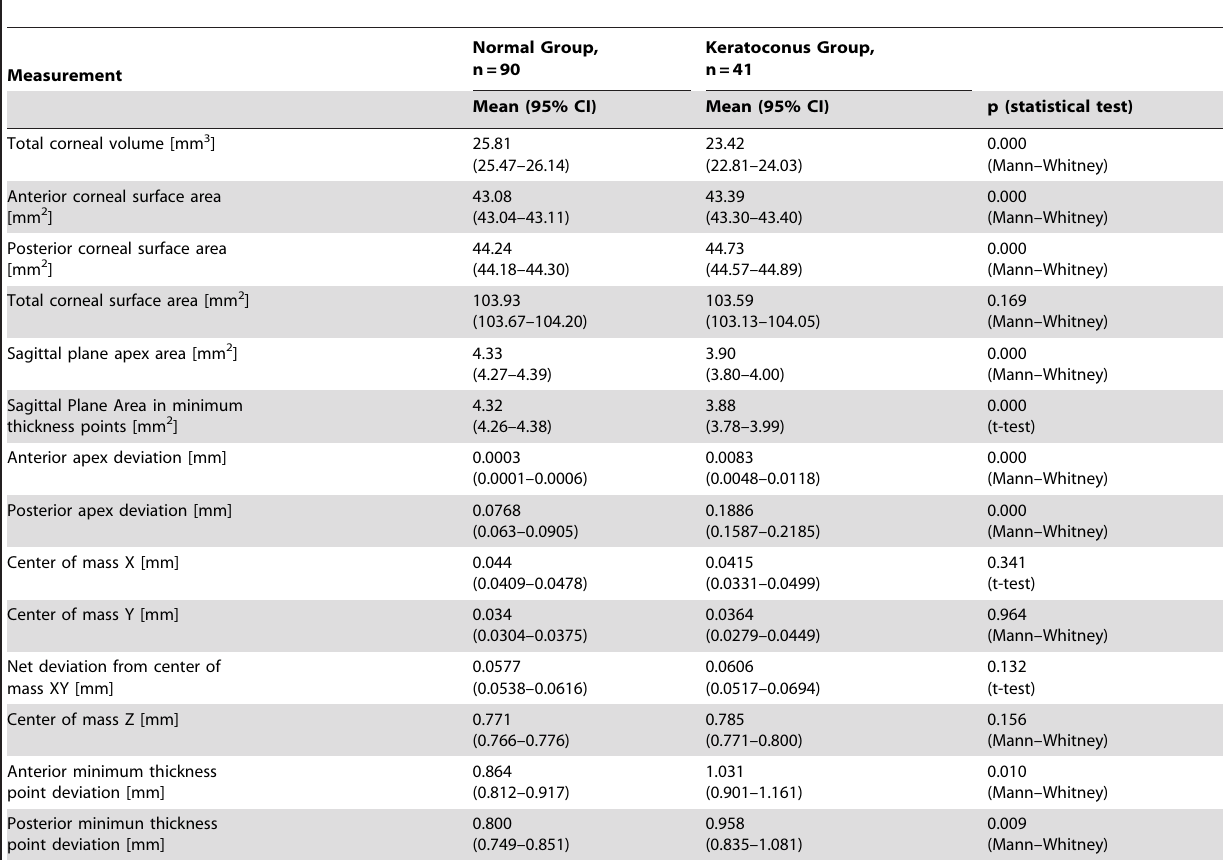
Table 1. Descriptive values (mean and 95% CI) and differences between normal and keratoconus corneal variables modeled.